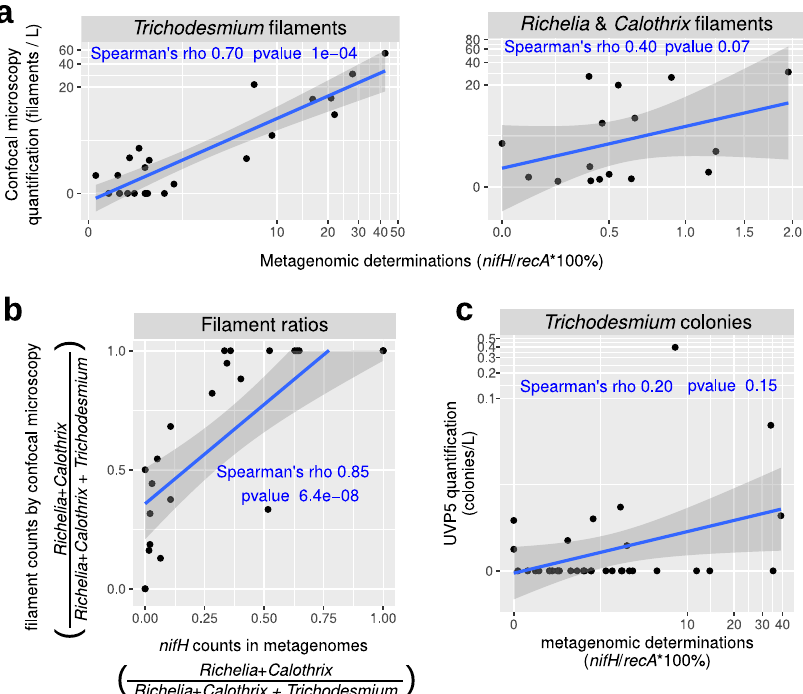
Fig. 6 Correlation analysis between diazotroph quanti fi cations by imaging and molecular methods. a , b Comparison between environmental high content fl uorescence microscopy (eHCFM 30 ) and metagenomics. Calothrix , Richelia , and Trichodesmium in samples from size fraction 20 – 180 μ m were measured by quanti fi cation of high-throughput confocal microscopy images ( fi laments L − 1 ) and by metagenomic counts (% of diazotrophs in the bacterioplankton community by the ratio between the marker genes nifH and recA ). a Correlation of relative abundances in metagenomes and absolute abundances by confocal microscopy for the three taxa. b Correlation between the ratio of abundances between taxa. c Comparison between Underwater Vision Pro fi ler 5 (UVP5 33 ) and metagenomics. Trichodesmium colonies were measured by UVP5 quanti fi cation (colonies L − 1 ) and by metagenomic counts in the 180 – 2000 µ m size-fractionated samples. Spearman ’ s rho correlation coef fi cients and uncorrected one-side p-values are displayed in blue. Source data are provided as a Source data fi